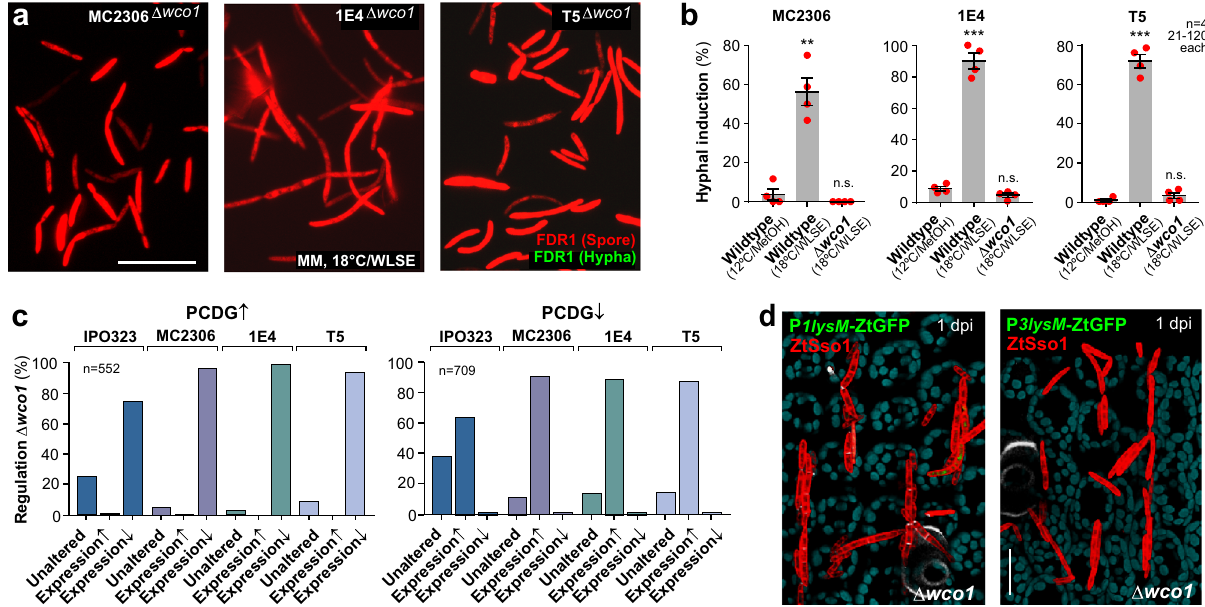
Fig. 8 | Gene expression in wco 1 null mutants, grown in hyphal-inducing con- ditions, in the genetic background of four wildtype strains. a Images of FDR1- encoded fl uorescent protein expression in Δ wco 1 mutants in the genetic back- ground of MC2306, 1E4 and T5 after 3 days at 18°C/WLSE. Spores only induce expression of mCherry (red), indicating the absence of dimorphic switching and con fi rming a pivotal role of WCC is pivotal to dimorphism of Z. tritici . Scale bar= 20 µ m. b Quantitative analysis of hyphal programme induction in FDR1-carrying Δ wco 1 mutants in the genetic background of MC2306, 1E4 and T5 after 3 days at 18°C/WLSE.Forcomparison,dataforwildtype(12°C/MetOHand18°C/WLSE)were taken from Fig. 3c). c Effect of wco 1 deletion on expression of Pan-strain Core Dimorphism Genes ↑ (PCDG ↑ ) and Pan-strain Core Dimorphism Genes ↓ (PCDG ↓ ). GeneexpressioninmutantsintheIPO323_ Δ Wco1,MC2306_ Δ Wco1,1E4_ Δ Wco1and T5_ Δ Wco1, grown at 18°C/WLSE, was compared to their respective wildtype pro- genitor. Note that less IPO323 genes are under the control of Wco1. See Supple- mentary Data 4. d In planta expression of GFP under the 1lysm promoter (P 1lysm -